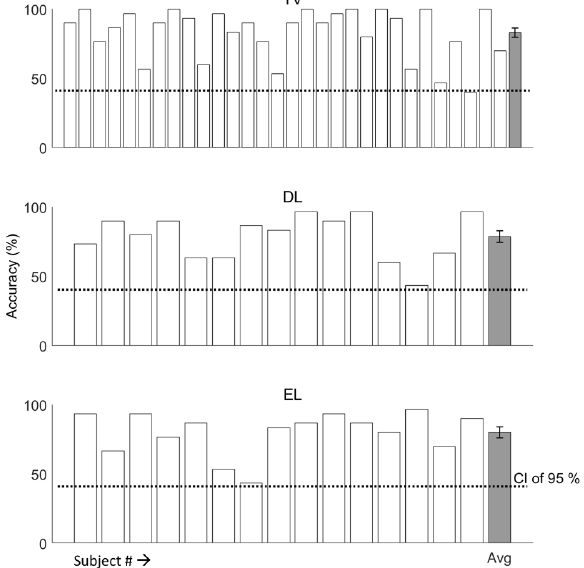
Figure 4. Online performance of three types of brain–computer interfaces (BCIs) to control TV, DL, and EL. The horizontal labels denote subject IDs. The grey bars show average accuracy. The dotted dark line of each device indicates the chance level of classification.